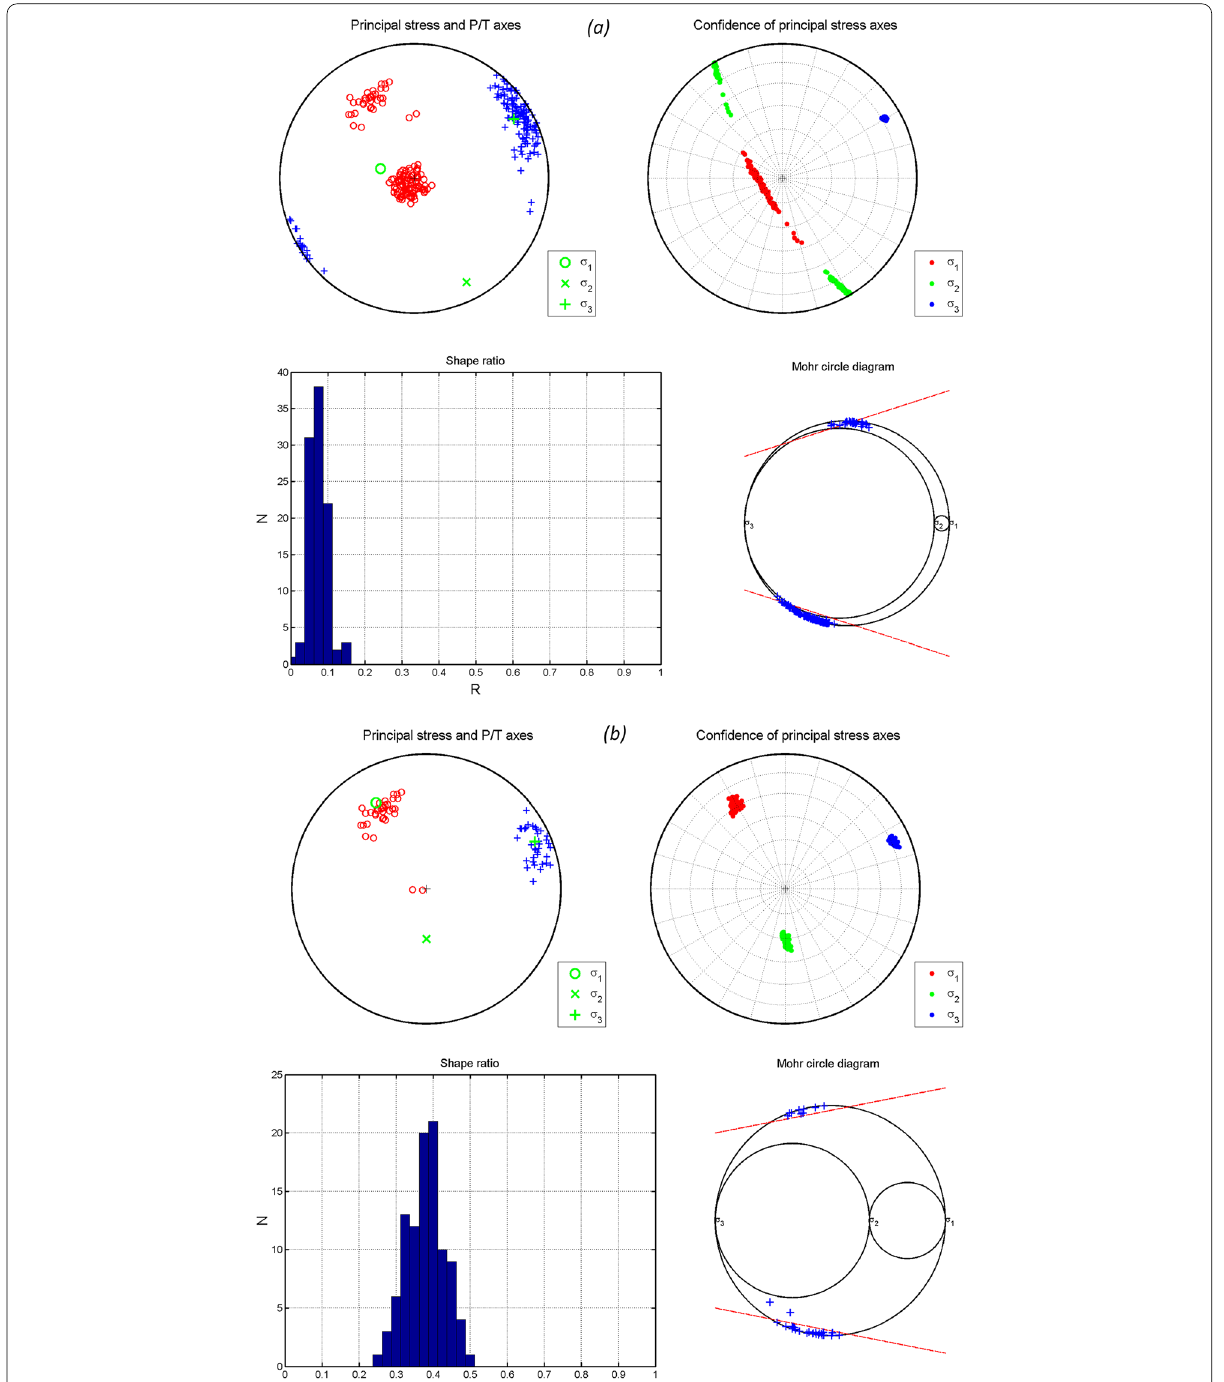
Fig. 11 Iterative joint inversion and fault orientations for the event listed in Additional file 1: Table S1 ( a ) for all events 1–136, ( b ) for events 1–35 that represent the activity on the NE fault trend and the foreshock stage, and (c) for events 36–136 that represent the activity on the NW fault trend and the foreshock–mainshock and aftershock stages. N is the number of realizations of random noise for accuracy estimates and R is the shape (stress) ratio, respectively, as shown in the shape ratio plot. Parameters σ 1 , σ 2 , and σ 3 are of the principal stresses as shown in stress and Mohr plots. In Mohr’s circles the red lines are inclined depending on the value of friction, representing by tan − 1